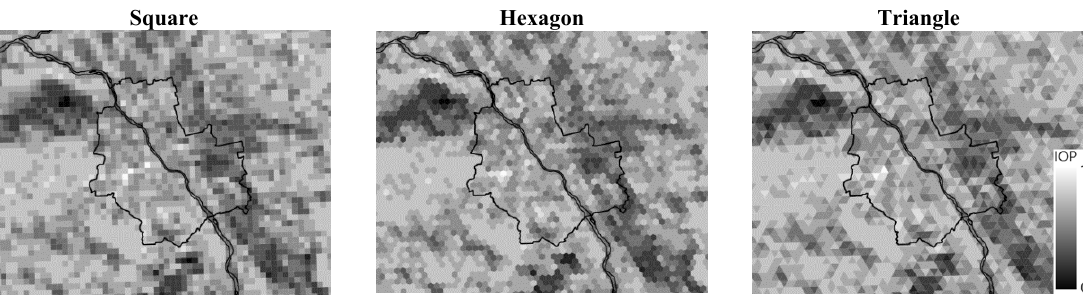
Figure 7. Fragments of passability maps generated for cells of a surface area of 1 km 2 and different shapes. Table 5. Correlation matrix and basic statistic parameters.